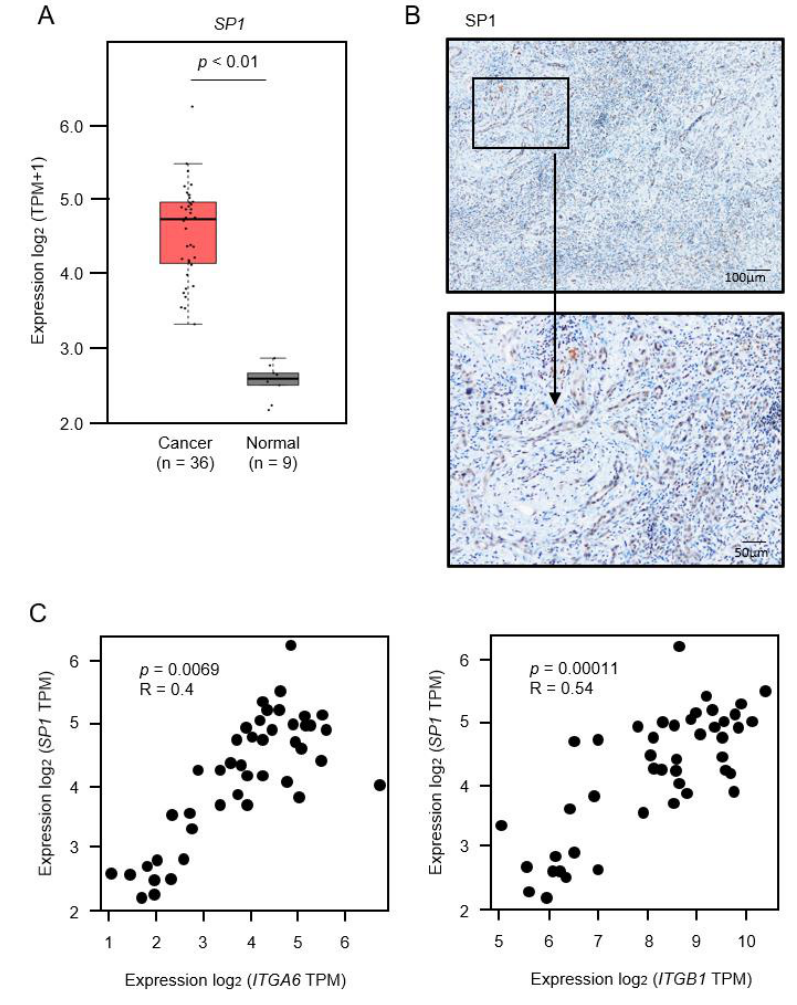
Figure 12. Expression of SP1 in intrahepatic cholangiocarcinoma (ICC) clinical specimens. ( A ) Ex- pression levels of SP1 in ICC tissues, normal tissues obtained from TCGA-CHOL through the GEPIA2 platform. ( B ) Immunostaining of SP1 in ICC clinical specimen. Areas in the boxed region above are shown magnified below (original magnification above: × 40, below: × 200). ( C ) Correlation of expression of SP1 / ITGA6 and SP11/ITGB1 in cholangiocarcinoma tissues through GEPIA2 platform. Pearson’s rank tests between the expression levels of SP1/ITGA6 and SP1/ITGB1 .